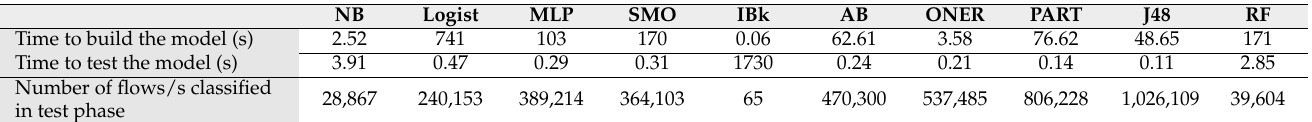
Table 10. Execution times (in training and test phases) in the Friday-Afternoon DDoS